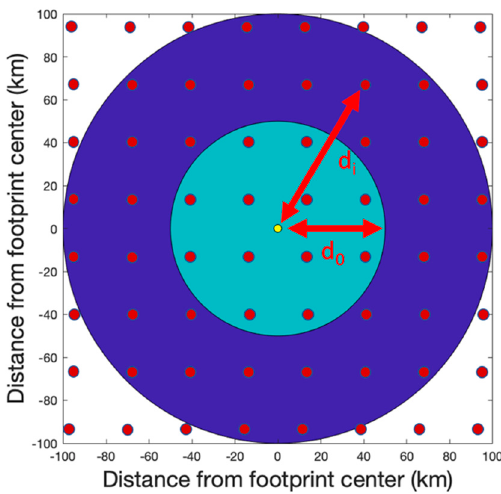
Figure 1. Schematic illustrating the relationship of the evaluation point (yellow circle), footprint size (2 d 0 = 100 km in this case, illustrating the situation for Aquarius) and model grid (red circles). C in Equation (1) corresponds to the set of all model grid points within the dark and light blue regions in this figure. Model grid points outside of this region were not used in estimating the SFV. The light blue region is the footprint for which weights, w i , are greater than 0.5. This figure is for illustration. For the model used in this study, the grid points would be much denser than depicted. This figure is taken from Reference [23].